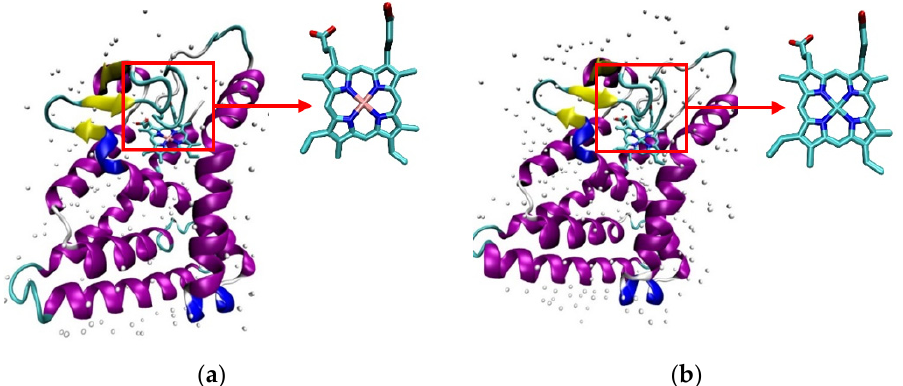
Figure 2. ( a ) The crystal structure of the REV-ERB β that forms a complex with iron protoporphy- rin IX (Agonist-REV-ERB β ). ( b ) The crystal structure of REV-ERB β that forms a complex with co- balt protoporphyrin IX (Antagonist-REV-ERB β ).